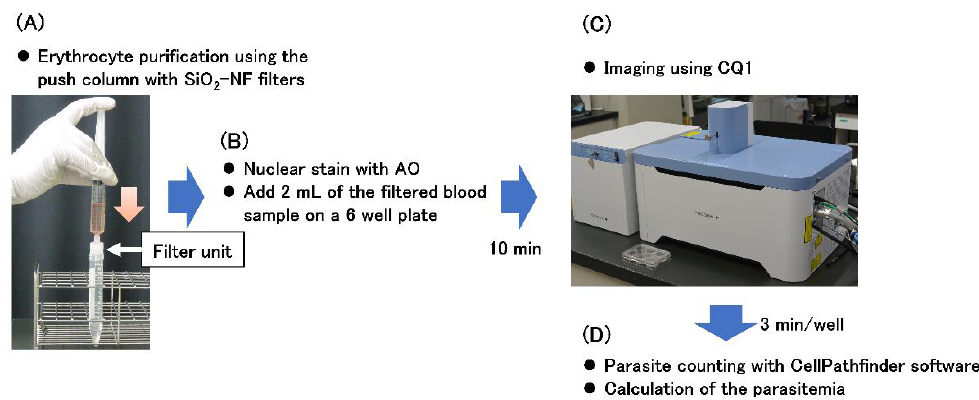
Figure 2. Protocol for highly sensitive quantitative detection of Plasmodium falciparum in blood using CQ1. Erythrocyte purification from diluted blood sample using the push column with SiO 2 -NF filters